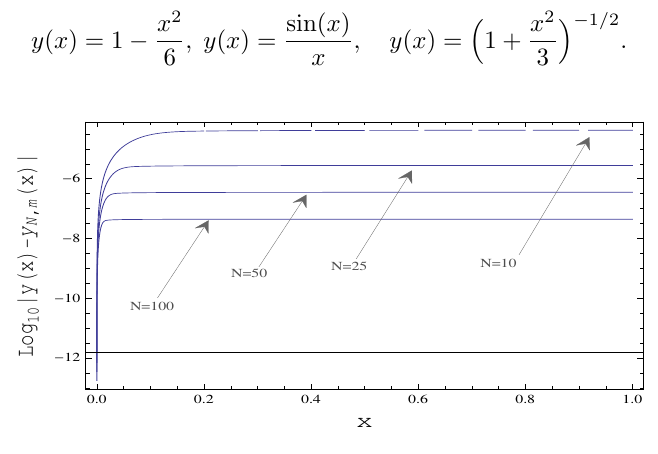
Figure 1. Absolute errors (in logarithmic scale) of approximations, for Example 1 with n = 0, m=10 iterations and N = 10 , 25 , 50 , 100.